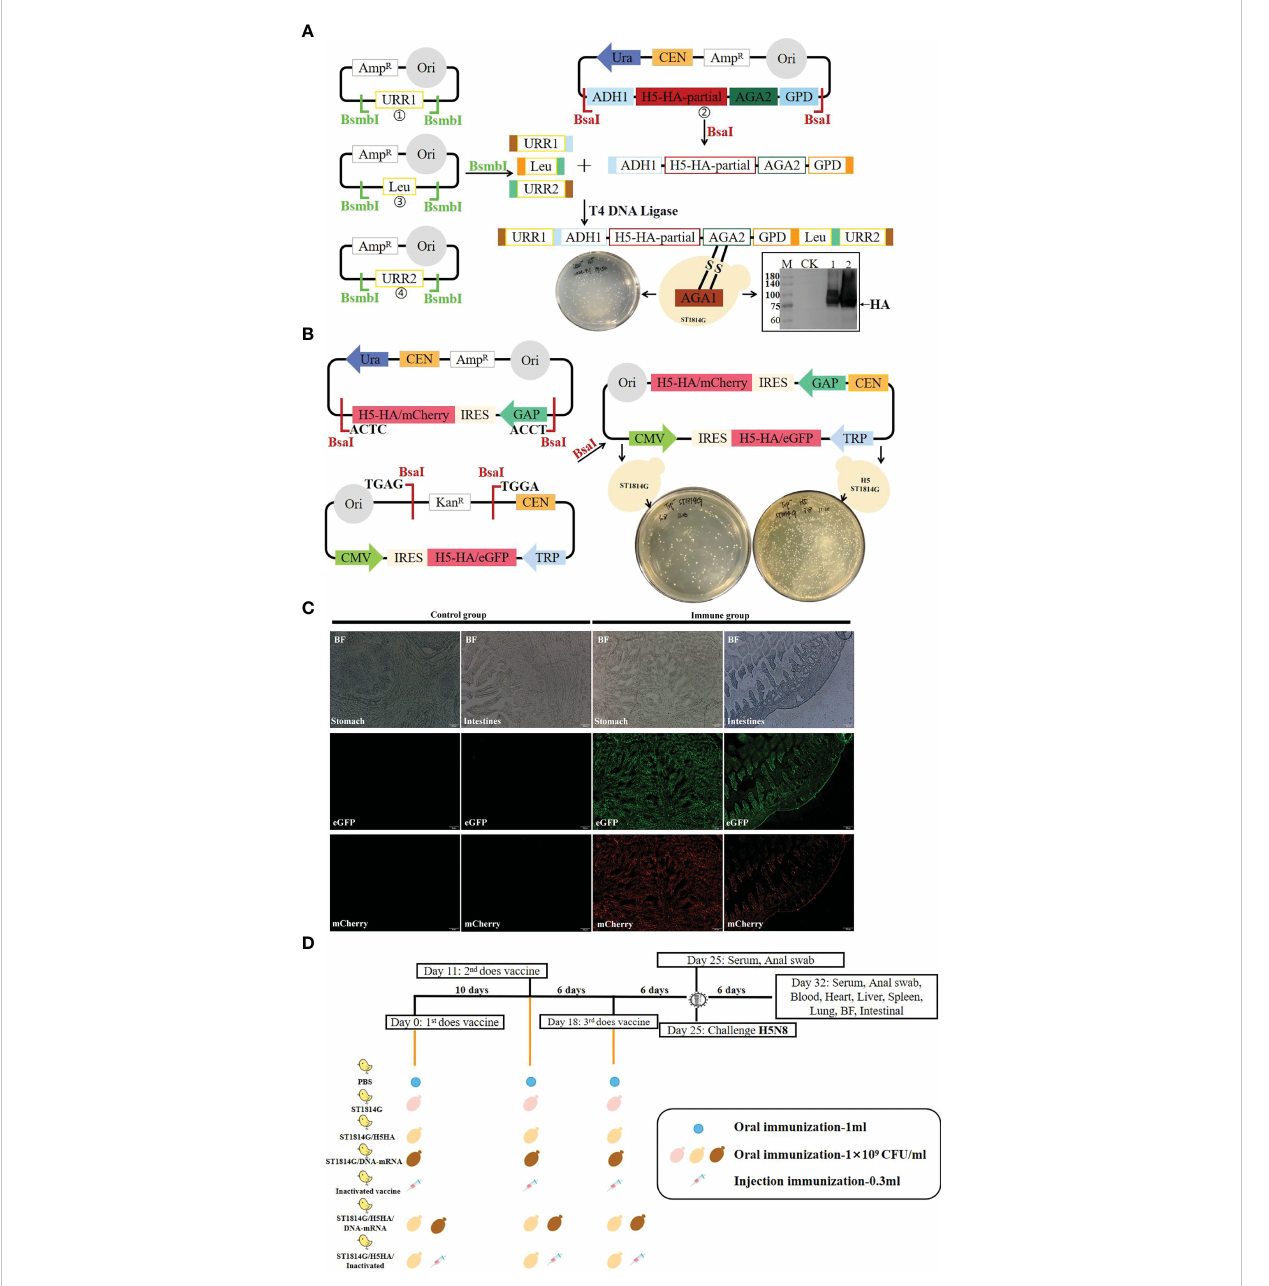
FIGURE 1 Schematic diagram of vaccines preparation, chicken vaccination and virus challenge experiments. (A) Preparation of protein subunit vaccine. The plasmids were constructed as described in Materials and Methods and then transformed into Saccharomyces cerevisiae ST1814G strain to prepare ST1814G/H5HA vaccine. Western blot analysis showed that HA protein could be expressed normally in ST1814G/H5HA vaccine. (M: protein marker; CK: ST1814G yeast lysates, lane 1-2: ST1814G/H5HA yeast lysates. (B) Preparation of DNA-RNA nucleic acid vaccine. The plasmids were constructed as described in Materials and Methods and then transformed into Saccharomyces cerevisiae ST1814G strain or ST1814G/H5HA strain to prepare ST1814G/DNA-RNA vaccine or ST1814G/H5HA/DNA-RNA vaccine. (C) Both the eGFP protein and the mCherry protein could be ef fi ciently expressed in stomach and intestine tissues of chickens. (D) Seven groups of two-week-old chickens were immunized as the schedule indicated and they were challenged intramuscularly with the H5N8 virus on the 6th day after the third